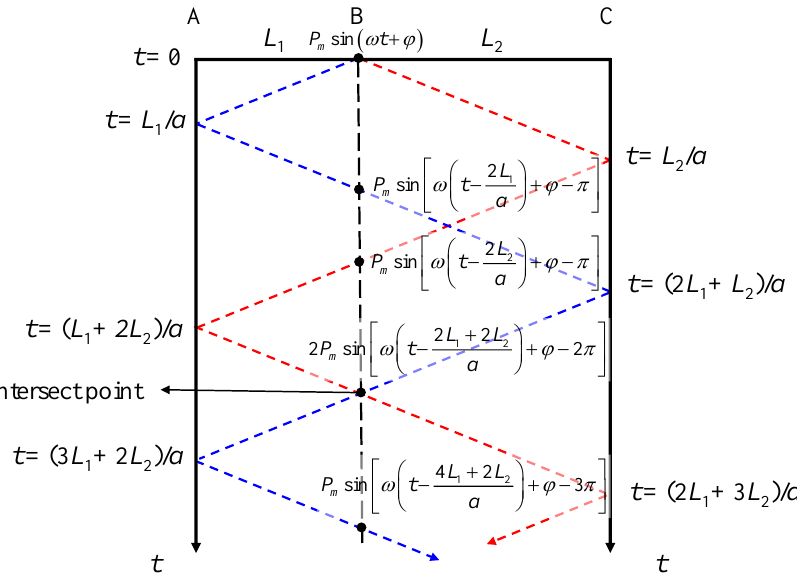
Figure 11. Graphical method of the traveling waves. The blue and red dashed lines in Figure 11 represent the traveling waves spreading to the left and right sides at the beginning. The time of the traveling wave spends reaching the reservoir boundary is marked on the left and right sides in Figure 11. The solid points represent the reflected waves that arrive at point B, and the expressions of the reflected waves are given nearby. The traveling waves are mapped to the time axis to obtain the time coordinates. It should be noted that the blue and red lines intersect with the black dashed line at the marked point in Figure 11, which means both the traveling waves cross the distance of 2 L 1 + 2 L 2 at time t = 2 L 1 + 2 L 2 a . The superimposed pressure oscillation at any location in the pipeline can be derived by summing all the solid points in the graphic within a specific time. For example, the pressure oscillation at point B in Figure 11 can be described as a piecewise function: